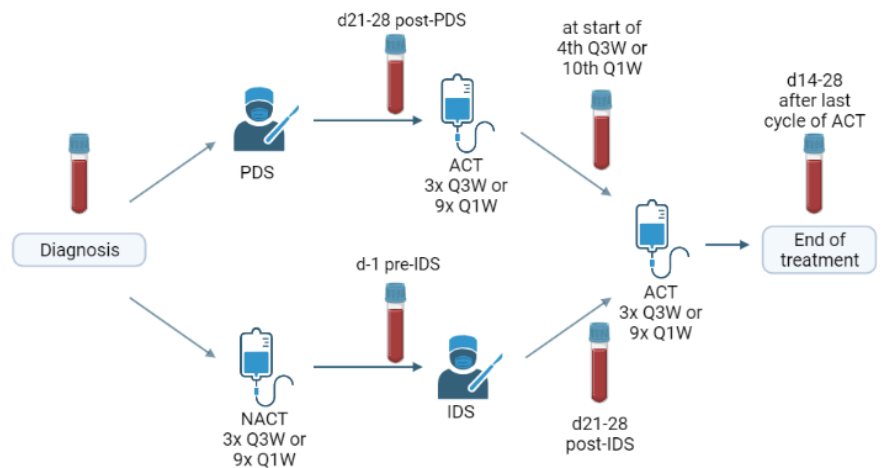
Figure 5. Schematic overview of treatment schedule and the timing of blood sampling. PDS: primary debulking surgery, IDS: interval debulking surgery, NACT: neoadjuvant chemotherapy, ACT: adjuvant chemotherapy, Q3W: once every three weeks, Q1W: weekly.